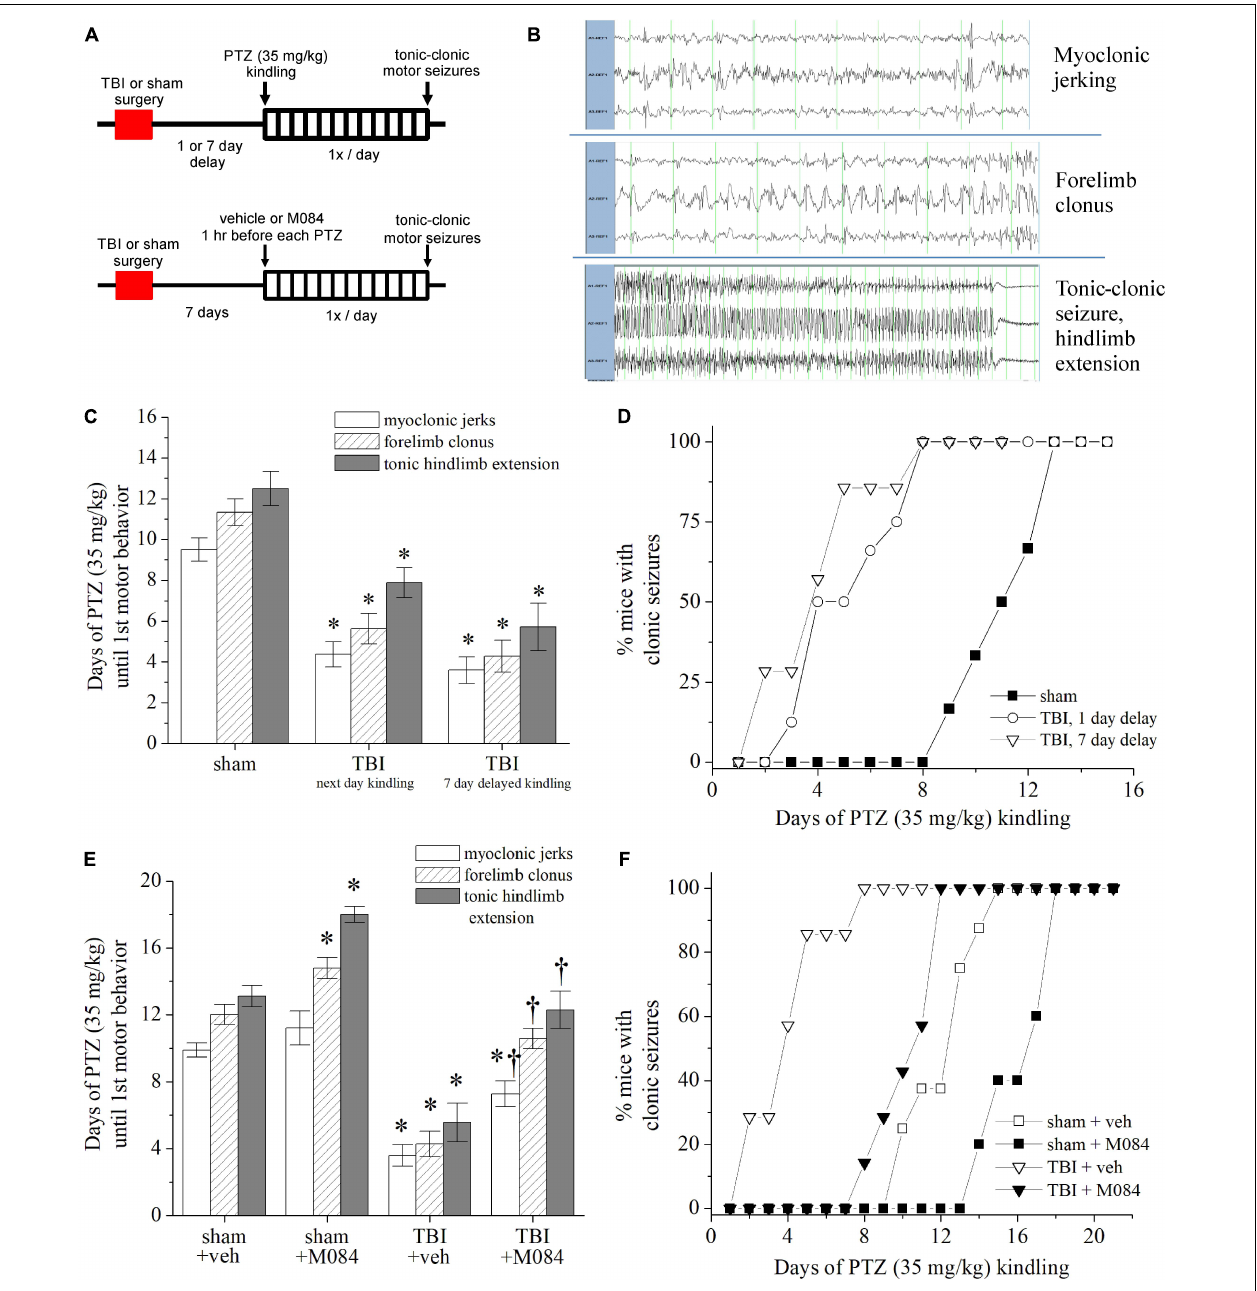
FIGURE 7 | Contribution of TRPC channels to posttrauma seizure susceptibility in mice. (A) Design schematic for pentylenetetrazol (PTZ) kindling after TBI in which daily 35 mg/kg PTZ challenge occurs 1 or 7 days after TBI (top) or concurrent M084 (10 mg/kg) 1 h before PTZ challenge (bottom). End-point criteria for kindling of mice was behavioral evidence of tonic–clonic motor seizure exhibited through tonic hindlimb extension. (B) Representative recordings of surface cortex and hippocampal depth electrode EEGs during the three distinct stages of PTZ-induced motor seizure activity: myoclonic jerks, forelimb clonus, and tonic hindlimb extension. (C) Rate of PTZ kindling initiated in sham mice, mice 1 day after TBI, and mice 7 days after TBI. Bars summarize the mean number of days required to elicit the motor behavioral activity. * p < 0.05 vs. sham. n = 6–8 mice per group. (D) Cumulative progression of mice achieving clonic seizures after daily PTZ challenge, as a percentage of total animals per group. TBI mice challenged after delaying 1 and 7 days showed similar rates of kindling and exhibited accelerated seizure activity compared to sham mice. (E) Rate of PTZ kindling 7 days after sham or TBI compared to mice treated with M084 from paradigm shown at the bottom figure of Panel (A) . Bars summarize the mean number of days required to elicit the motor behavioral activity. M084 treatment significantly impeded the progression of seizures compared to untreated TBI animals. (F) Cumulative progression of M084-treated mice achieving clonic seizures after daily PTZ challenge, as a percentage of total animals per group. * p < 0.05 vs. sham + veh., † p < 0.05 vs. TBI + veh. n = 6–7 mice per group. Statistical comparisons were made with the Mann–Whitney U test. All data bars represent the mean ± SEM.